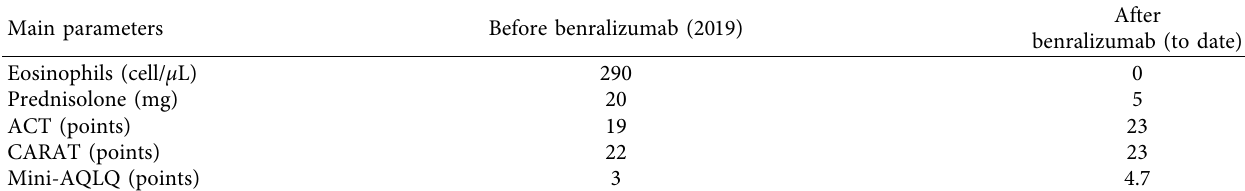
Table 2: Changes in clinical parameters during the patient follow-up